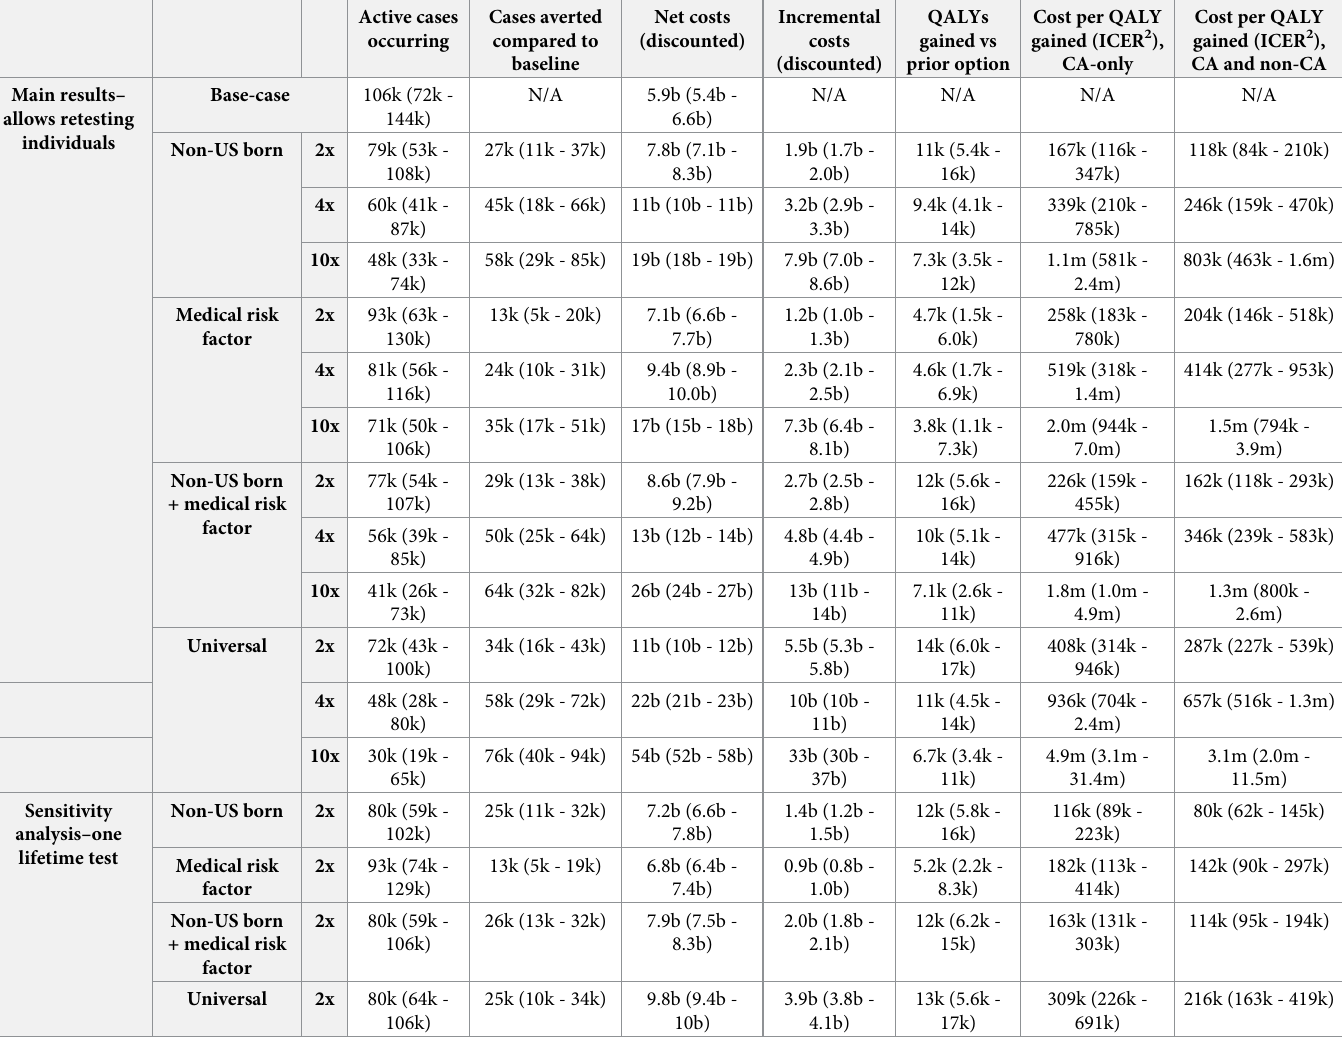
Table 3. Cost-utility results of TB targeted testing and treatment strategies by target population, 2017–2065. costs in 2015